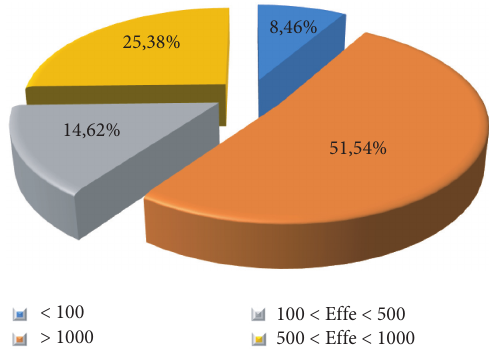
Figure 9: Number of participating